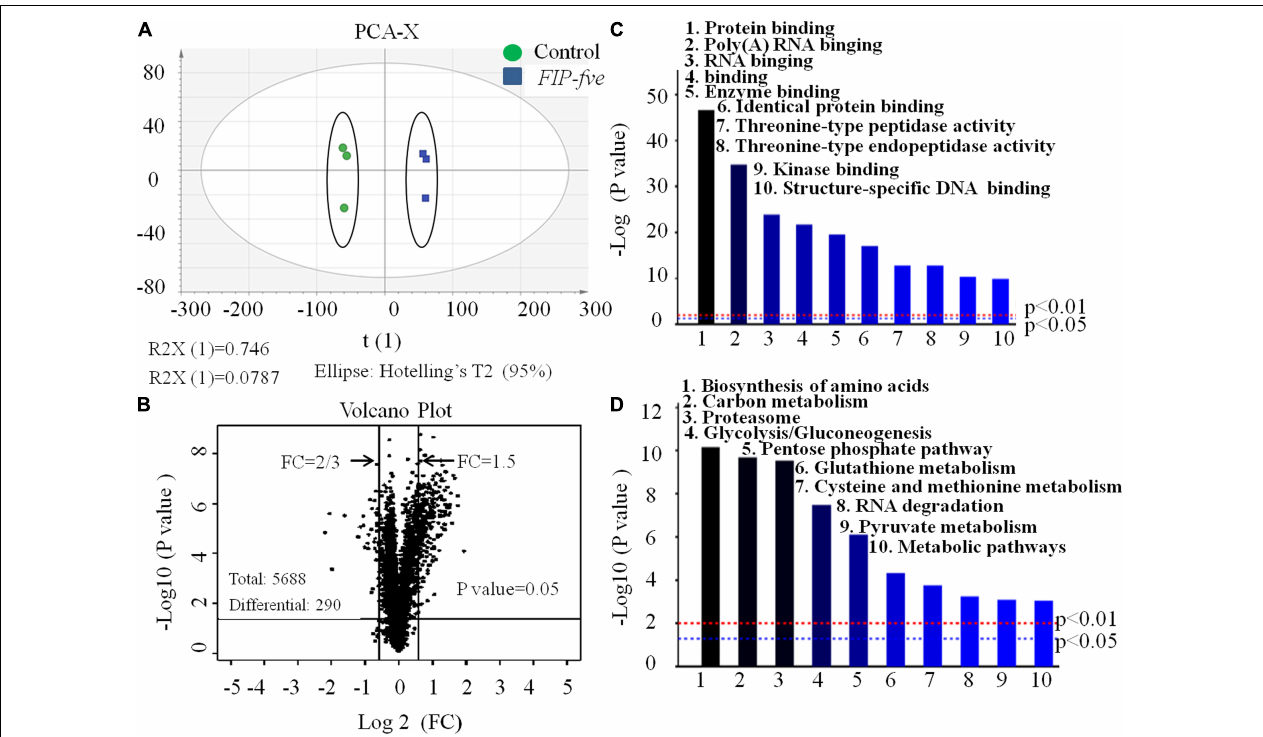
FIGURE 4 | Gene Ontology (GO) molecular function (MF), and Kyoto Encyclopedia of Genes and Genomes (KEGG) analysis of expression of intracellular proteins in FIP-fve -stimulated Jurkat E6-1 cells. (A) PCA analysis. (B) Volcanic map. A black dot in the picture represents a protein. The proteins in the range of FC > 1.5 and FC < 2/3 were differentially expressed proteins. Analysis of GO MF enrichment (C) and KEGG (D) pathway were conducted by Proteome Discoverer TM 2.2 software based on 290 differential expressed